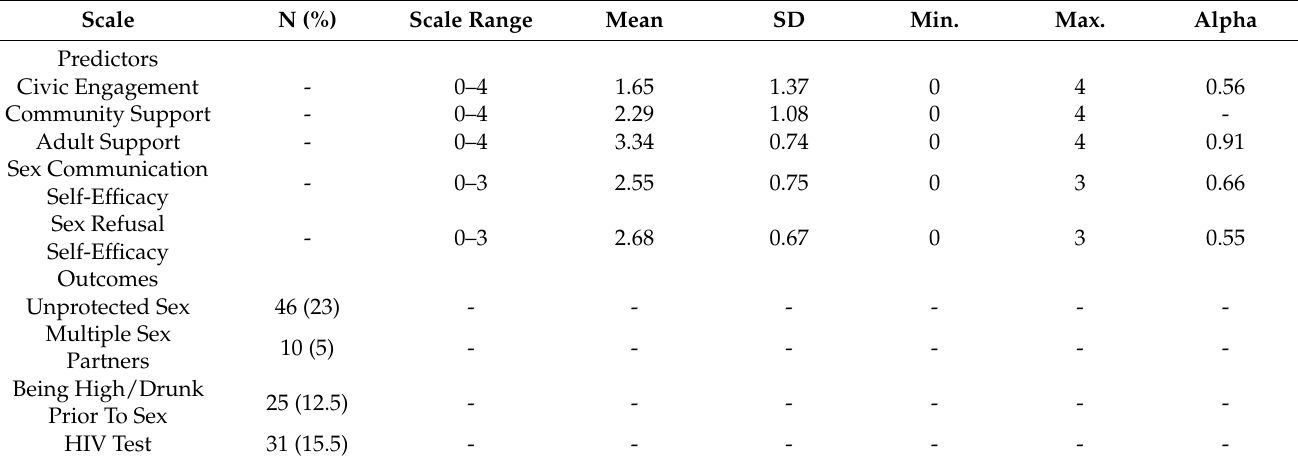
Table 1. Predictor and outcome variables descriptive